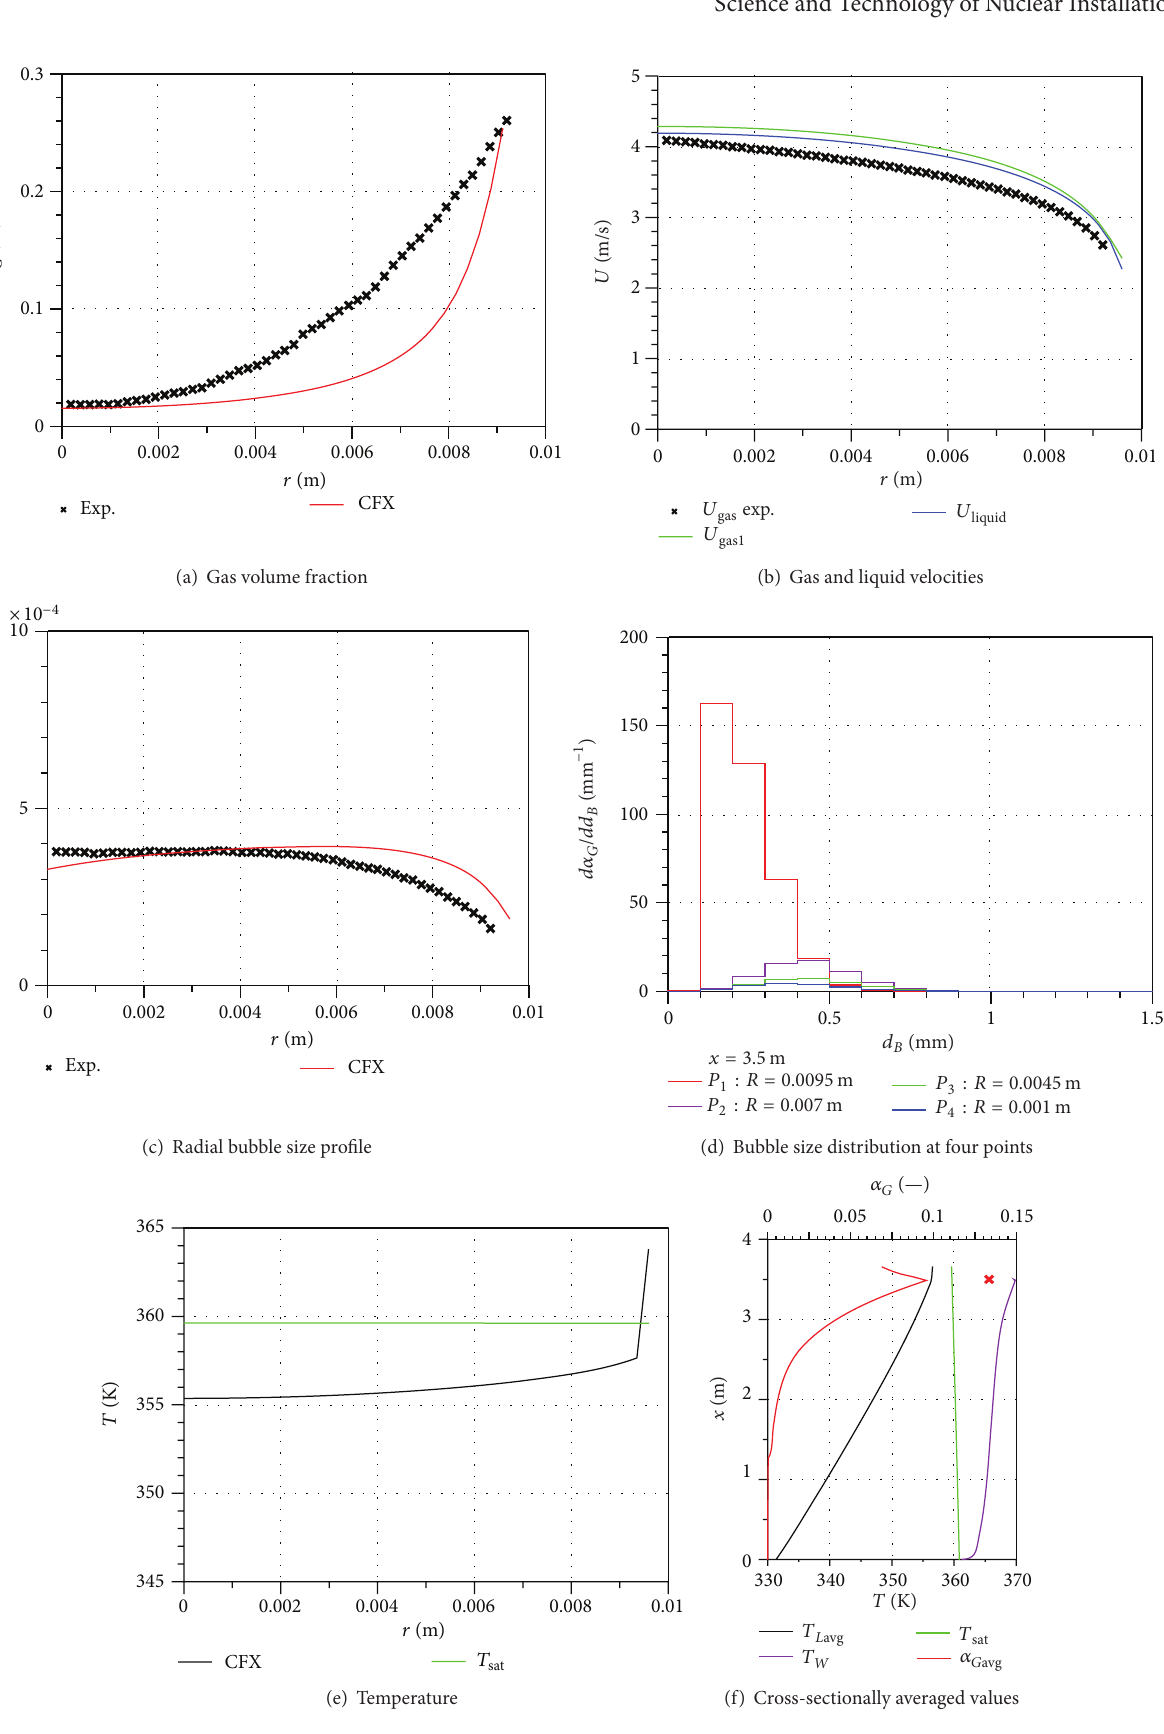
F 8: Comparison of measured and calculated values for